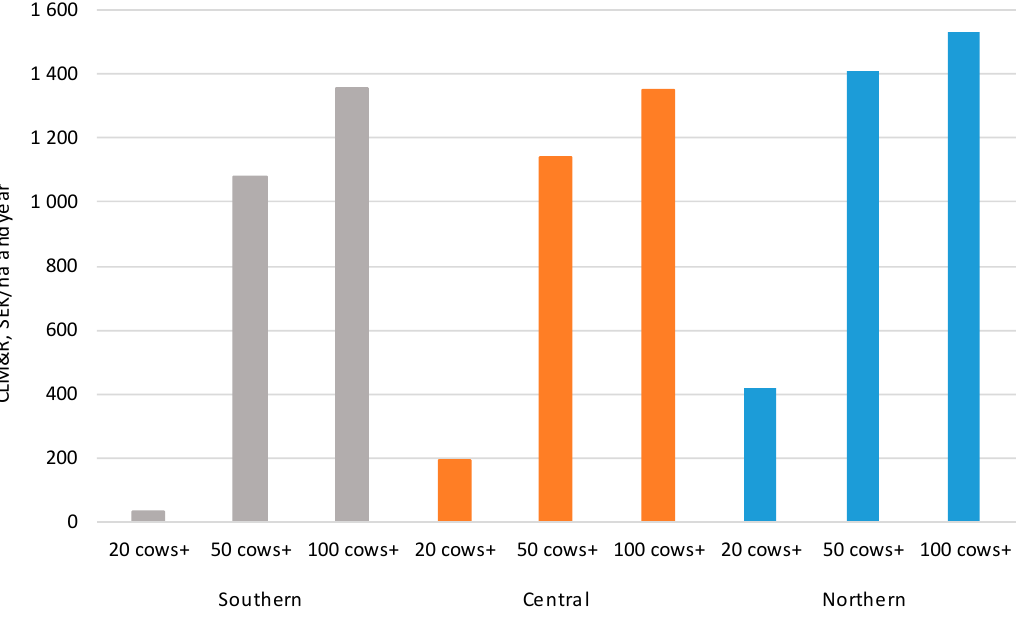
Figure 4. Basic calculation of contribution to land, management, and risk (CLM&R) in organic suckler cow-based beef production in herds with 20, 50, and 100 cows + grazing on large pasture-forest mosaics in southern, central, and northern Sweden. Cows + is beef suckler cows + rearing of their calves to slaughter and replacement.